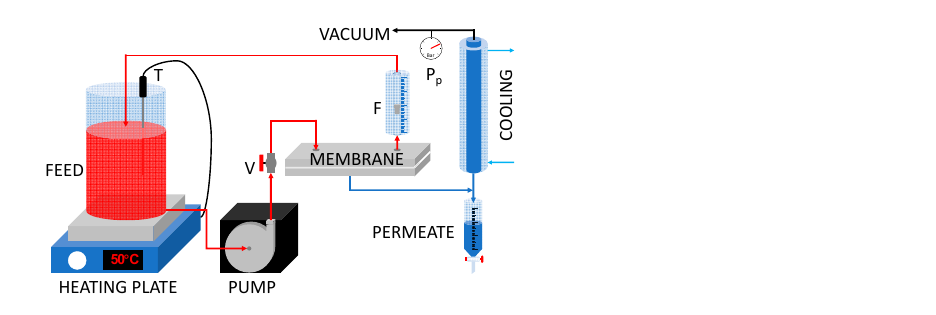
Table 2. VMD tests